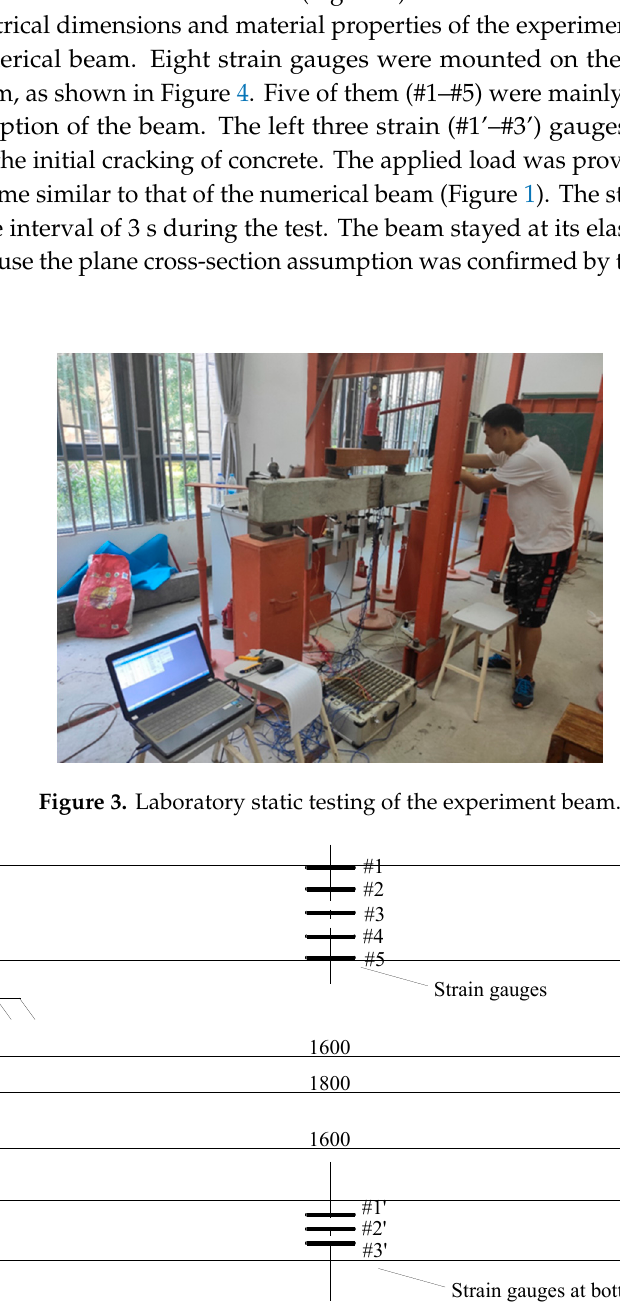
Figure 4. Strain gauge layout of the experimental beam (unit: mm).